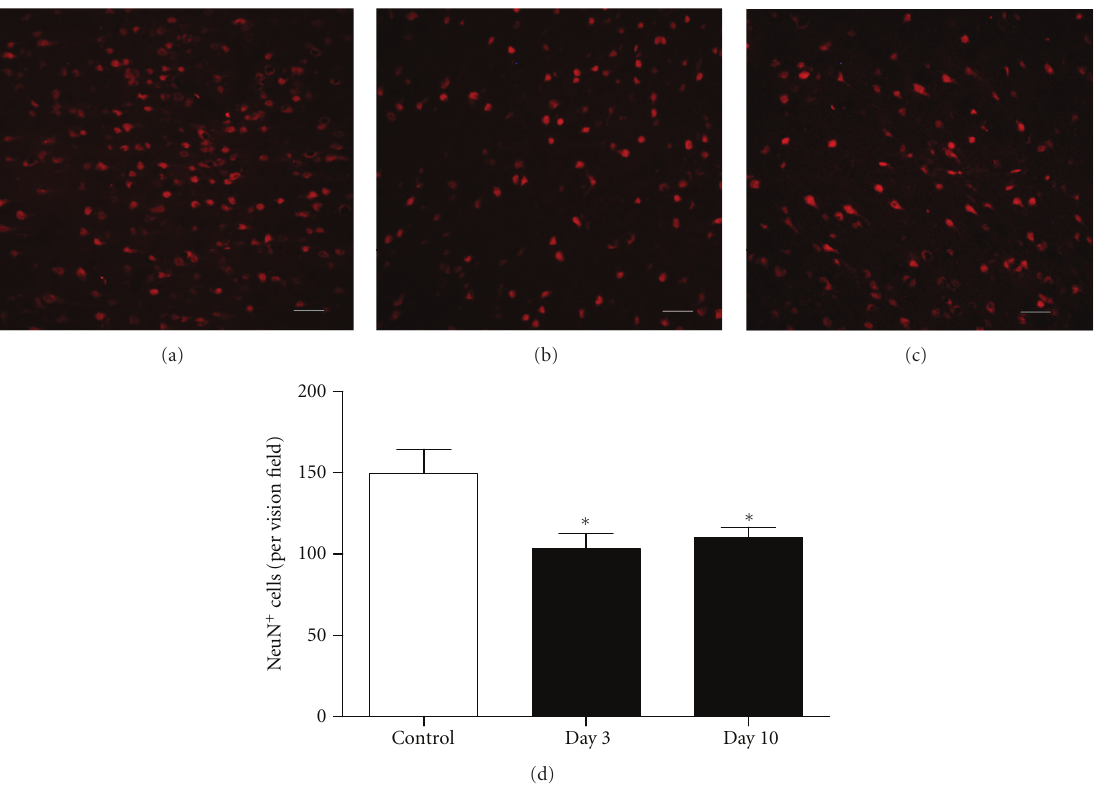
Figure 7: NeuN immunofluorescent labeling was performed for neuron quantification ((a) control group; (b) day 3 SAH group; (c) day 10 SAH group). NeuN-positive cells decreased significantly in day 3 and day 10 groups. There was no statistical di ff erence between two SAH groups. ∗ P < 0 . 05 versus control group. Bars represent the mean ± SEM ( n = 4, each group). (Scale bar, 50 μ m).